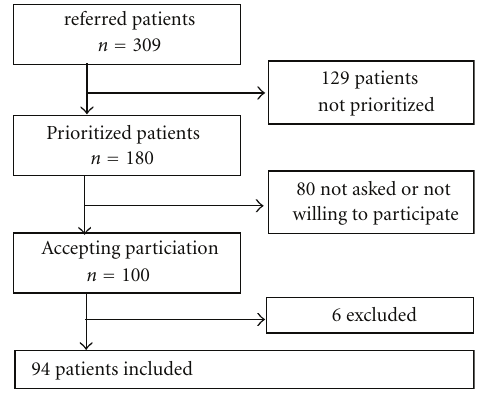
Figure 1: Flow chart depicting extraction of the 94 eligible patients observed in the